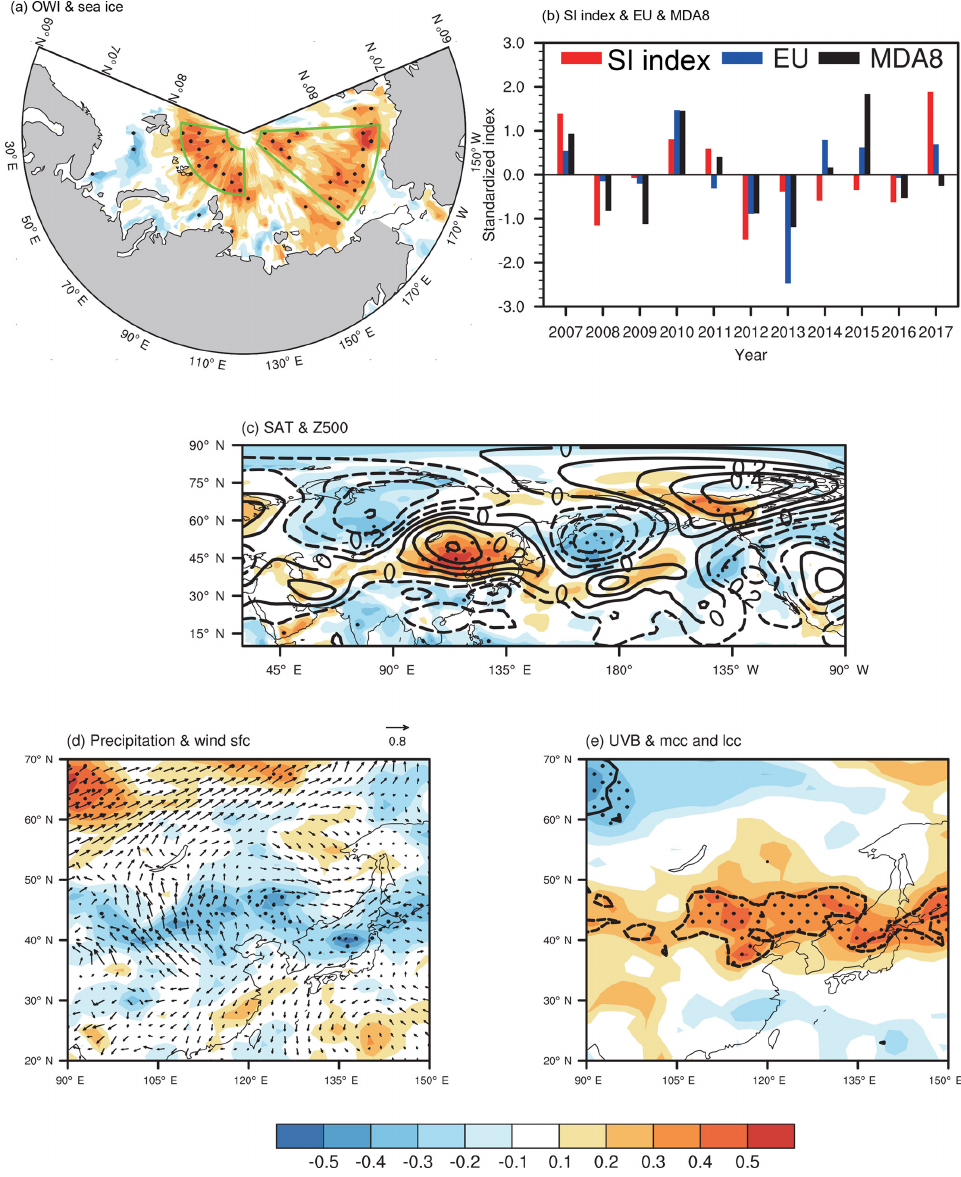
Figure 10. The role of the Arctic sea ice. (a) The correlation coefficients between the JJA mean OWI and May sea ice. (b) The variation in the May SI index (red bar, area-averaged sea ice of the green boxes in a ), JJA mean EU pattern index (blue bar) and JJA mean observational SDZ MDA8 (black bar) from 2007 to 2017. (c) The correlation coefficients between the May SI index and surface air temperature (shading), and geopotential height at 500hPa (contour) from 1979 to 2017. The black dots indicate that the CC with surface air temperature was above the 95% confidence level. (d) The correlation coefficients between the May SI index and precipitation (shading), surface wind (arrow), (e) downward UV radiation at the surface (shading), and sum of low and medium cloud cover (contour) from 1979 to 2017. The black dots indicate that the shading CC with precipitation (d) and downward UV radiation (e) was above the 95% confidence level. The data used here are from ERA-Interim